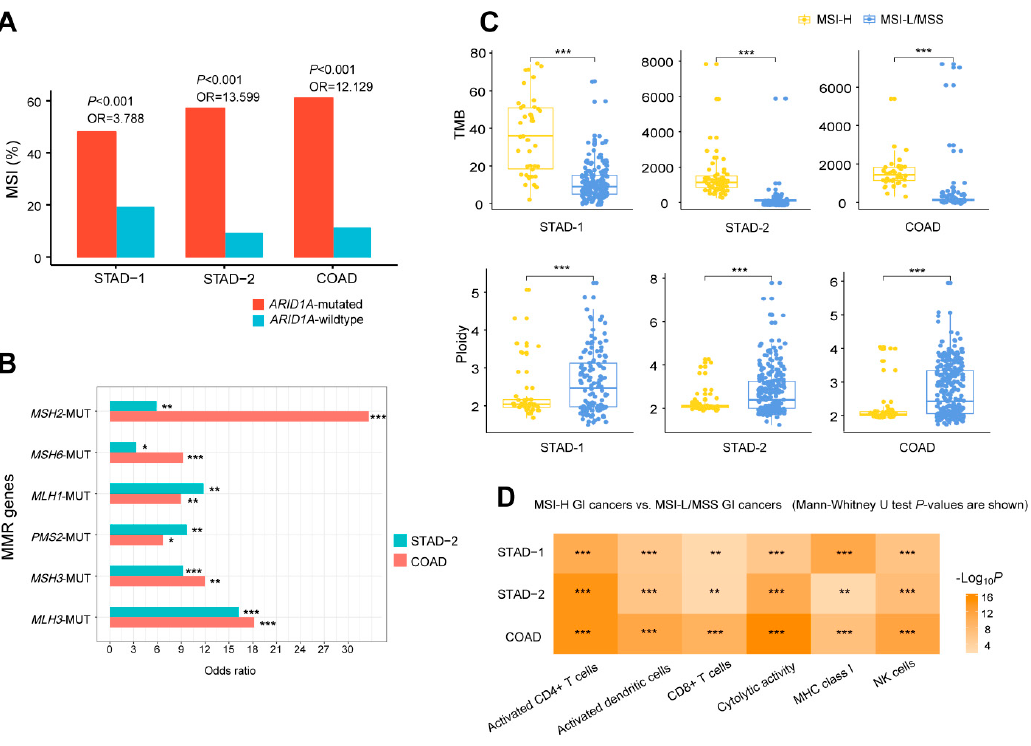
Figure 3. ARID1A mutations are associated with the microsatellite instability (MSI) genomic feature of GI cancers. ( A ) ARID1A -mutated GI cancers harbor a significantly higher proportion of MSI cancers than ARID1A -wildtype GI cancers (Fisher's exact test, P < 0.001). OR: odds ratio. ( B ) The ARID1A mutation significantly co-occurs with the mutation of mismatch repair (MMR) genes (Fisher's exact test, P < 0.001). MUT: mutation. ( C ) The MSI-high (MSI-H) GI cancers have significantly higher TMB and significantly lower aneuploidy levels than the MSI-low (MSI-L) and microsatellite stable (MSS) GI cancers (Mann-Whitney U test, P < 0.001). ( D ) MSI-H GI cancers have significantly stronger immune signatures than MSI-L/MSS GI cancers (Mann-Whitney U test, P < 0.01). * P < 0.05, ** P < 0.01, *** P < 0.001.